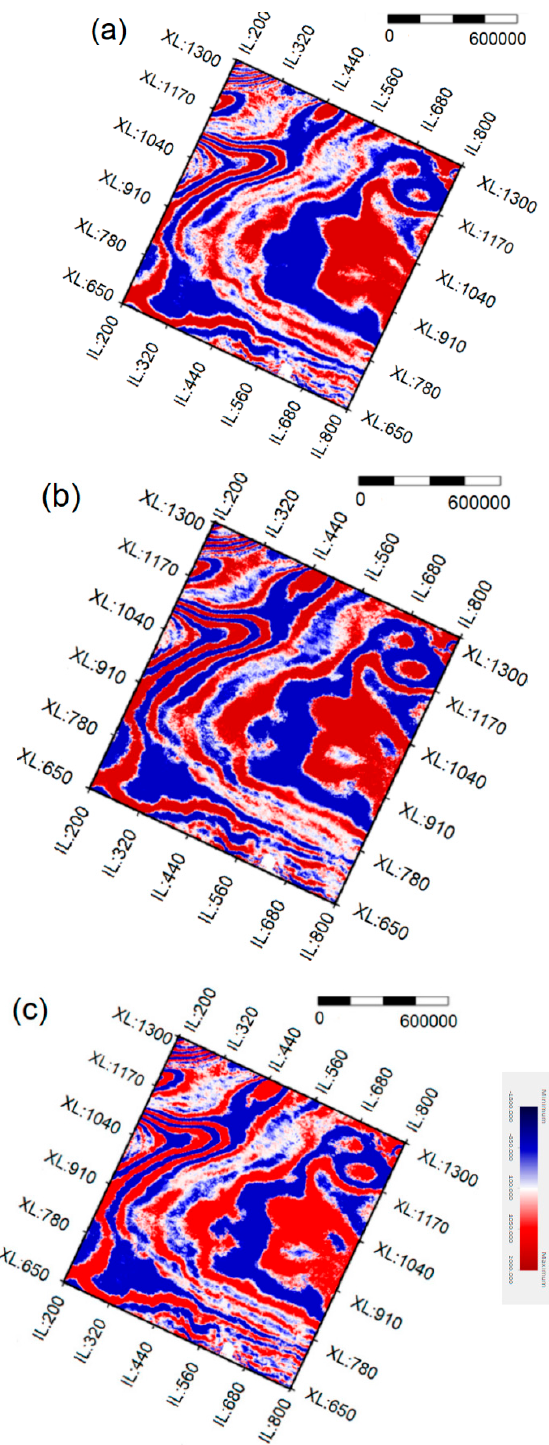
Figure 15. Time slices at 2000 ms that show the deconvolution results obtained: ( a ) from the original data; ( b ) by the algorithm proposed in this study; and, ( c ) by conventional ISTA.